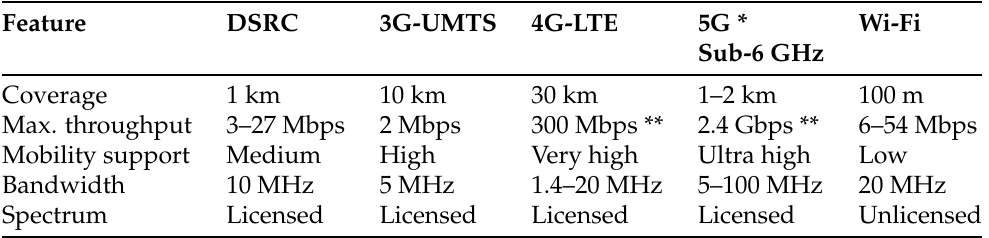
Table 1. Comparison between some wireless communication technologies for on-the-road vehicular communications